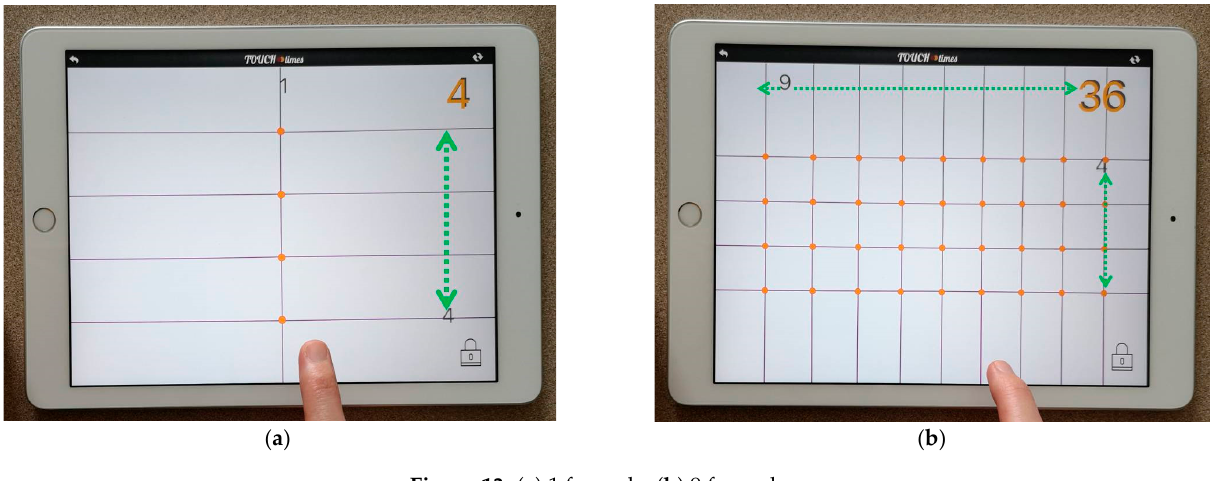
Figure 13. ( a ) 1 four-ple; ( b ) 9 four-ples.